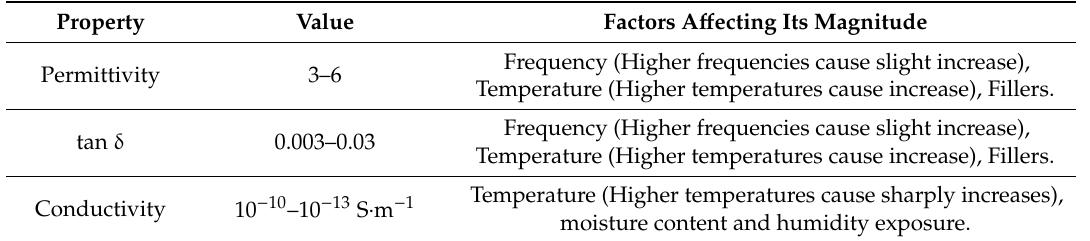
Table 4. Electrical properties of epoxy resins (information adapted from [26]).